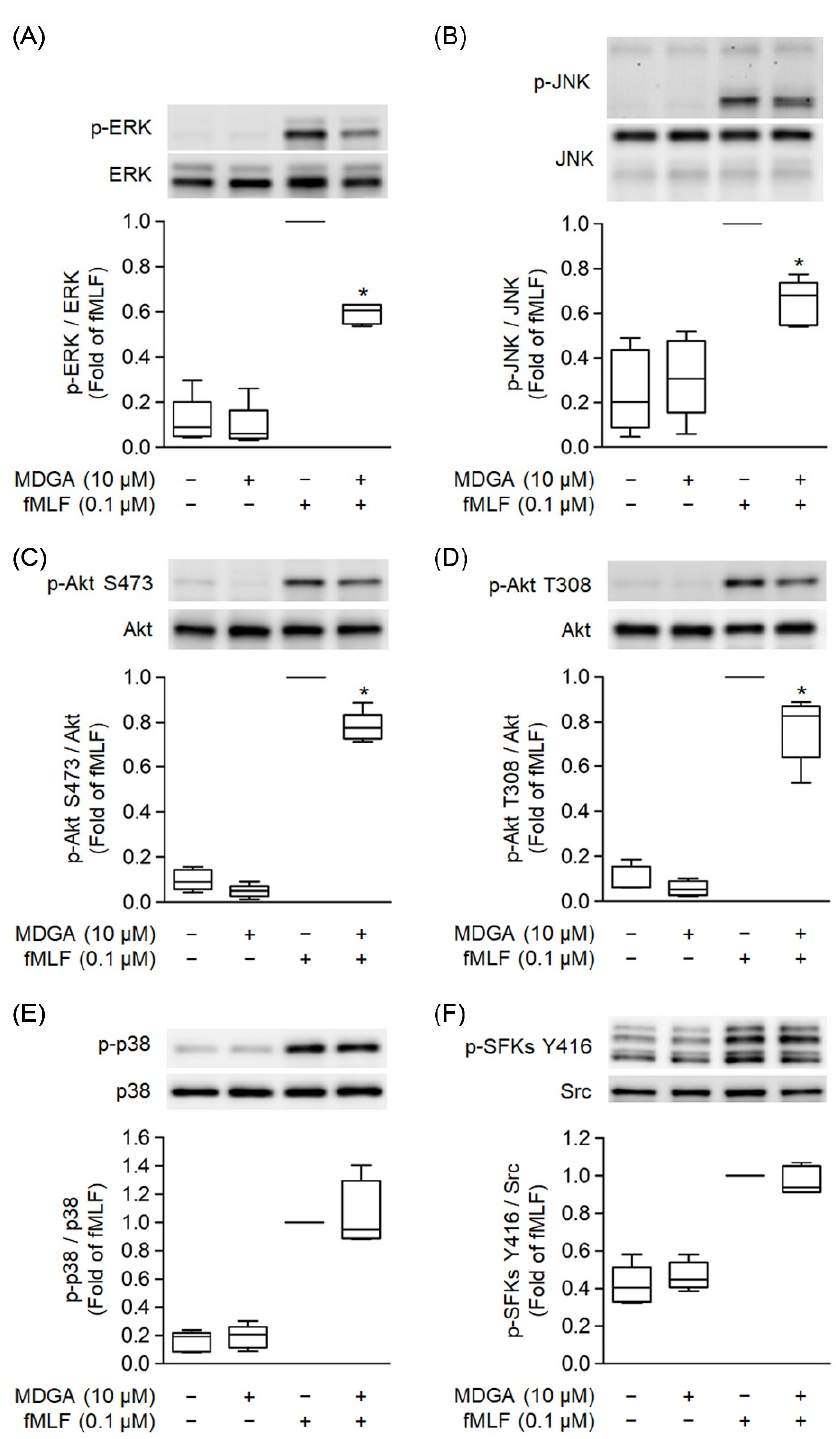
Figure 7. meso -Dihydroguaiaretic acid (MDGA) inhibits phosphorylation of ERK, JNK, and Akt, but not p38, SFKs in activated neutrophils. DMSO (0.1%) or MDGA (10 µ M)-treated neutrophils were activated with or without fMLF. Phosphorylation of ( A ) ERK, ( B ) JNK, ( C ) Akt S473, ( D ) Akt T308, ( E ) p38, and ( F ) SFKs Y416 was assessed with immunoblotting using antibodies against the phosphorylated and native (total) forms of each protein. Blotted bands were analyzed with a densitometer, and the quantitative ratios of all samples were normalized to the corresponding total protein. All data are expressed as the mean ± S.E.M; ( n = 5). * p < 0.05 vs. stimulated